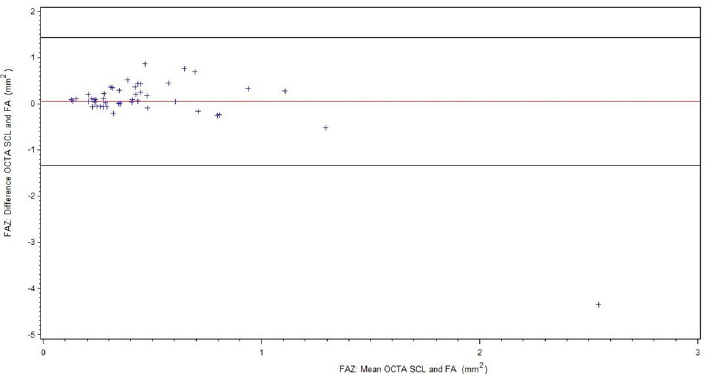
Fig 3. FAZ: Bland-Altman-Plot for the agreement of FA and OCTA SCL for all patients.